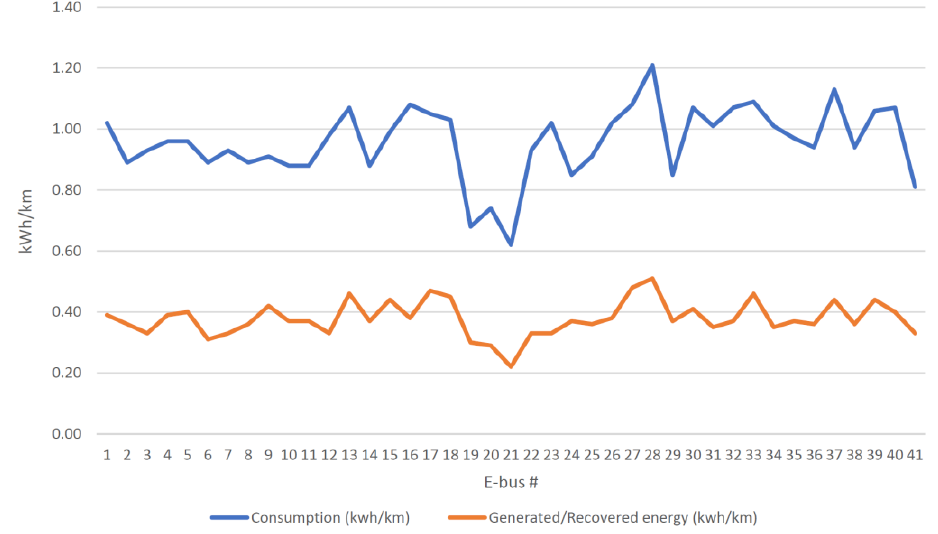
Figure 6. Energy balance of the fleet of electric buses (kWh/km).